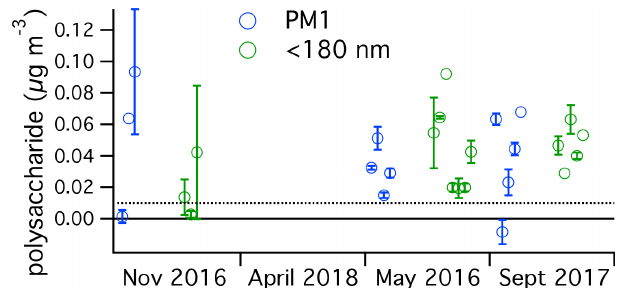
Figure 4. Ambient concentrations of polysaccharide in submicron (blue) and sub-180nm (green) aerosol determined in this study over the four NAAMES cruises, organized by season. The dotted line represents the estimated detection limit. One sample was lower than the estimated background, resulting in a negative calculated concen- tration. All samples were above the estimated detection limit prior to background subtraction. The similar absolute values in the two size fractions imply that most of the submicron polysaccharide was present in sub-180nm